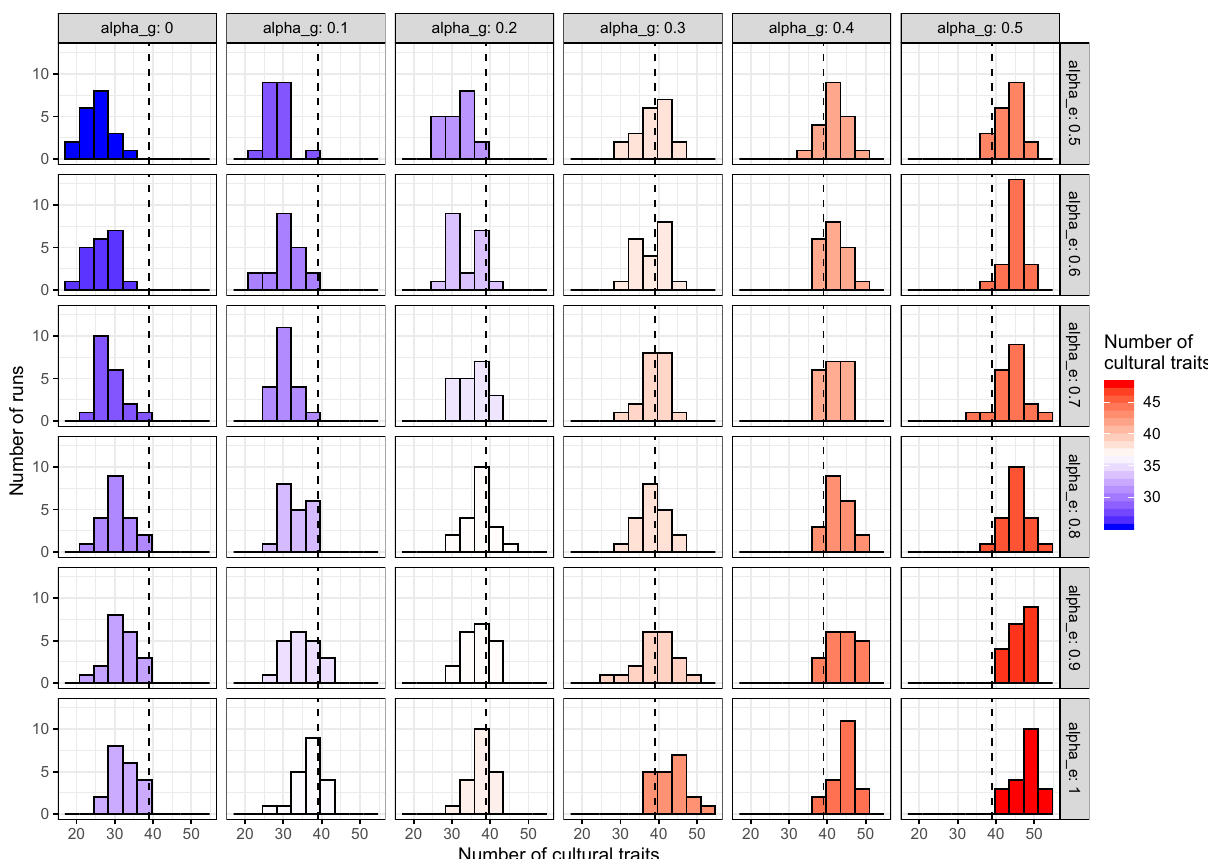
Figure 1. Number of cultural traits in oranzees, when varying ecological and genetic diversity. Red color indicates simulation runs that produced more than 38 cultural traits (the number of cultural traits identified in 1); blue color indicates simulation runs that produced less than 38 cultural traits. For all simulations, S = 1 , α e and α g as indicated in the plot. N = 20 runs for each parameters combination. See SI for other values of S , α e , and α g , including all equal to